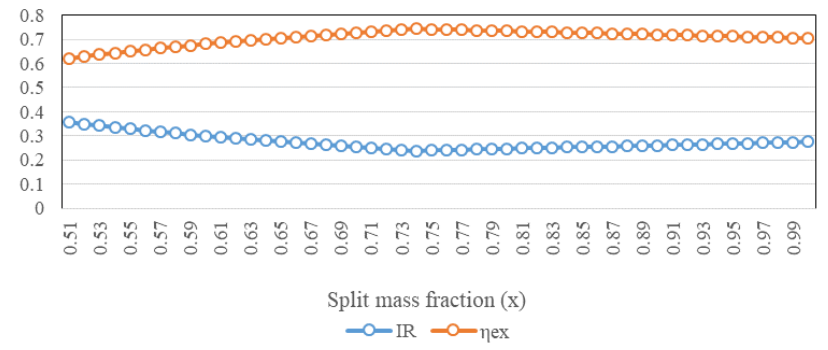
Figure 5. Exergy e ffi ciency ( η ex ) and irreversibility ratio ( IR ) of the sCO 2 cycle at a turbine inlet Figure 5. Exergy efficiency ( η ex ) and irreversibility ratio ( IR ) of the (cid:1871)(cid:1829)(cid:1841) (cid:2870) cycle at a turbine inlet temperature ( T 7 ) of 700 ◦ C. temperature ( T 7 ) of 700 °C. Figure 5. Exergy efficiency ( η ex ) and irreversibility ratio ( IR ) of the (cid:1871)(cid:1829)(cid:1841) (cid:2870) cycle at a turbine inlet temperature ( T 7 ) of 700 °C.